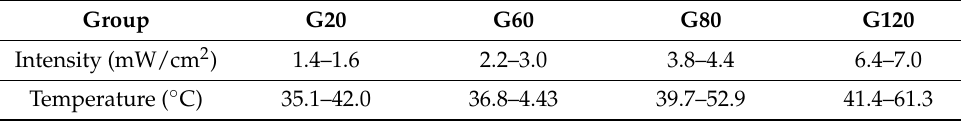
Table 1. Intensity and temperature of post ‐ curing equipment.